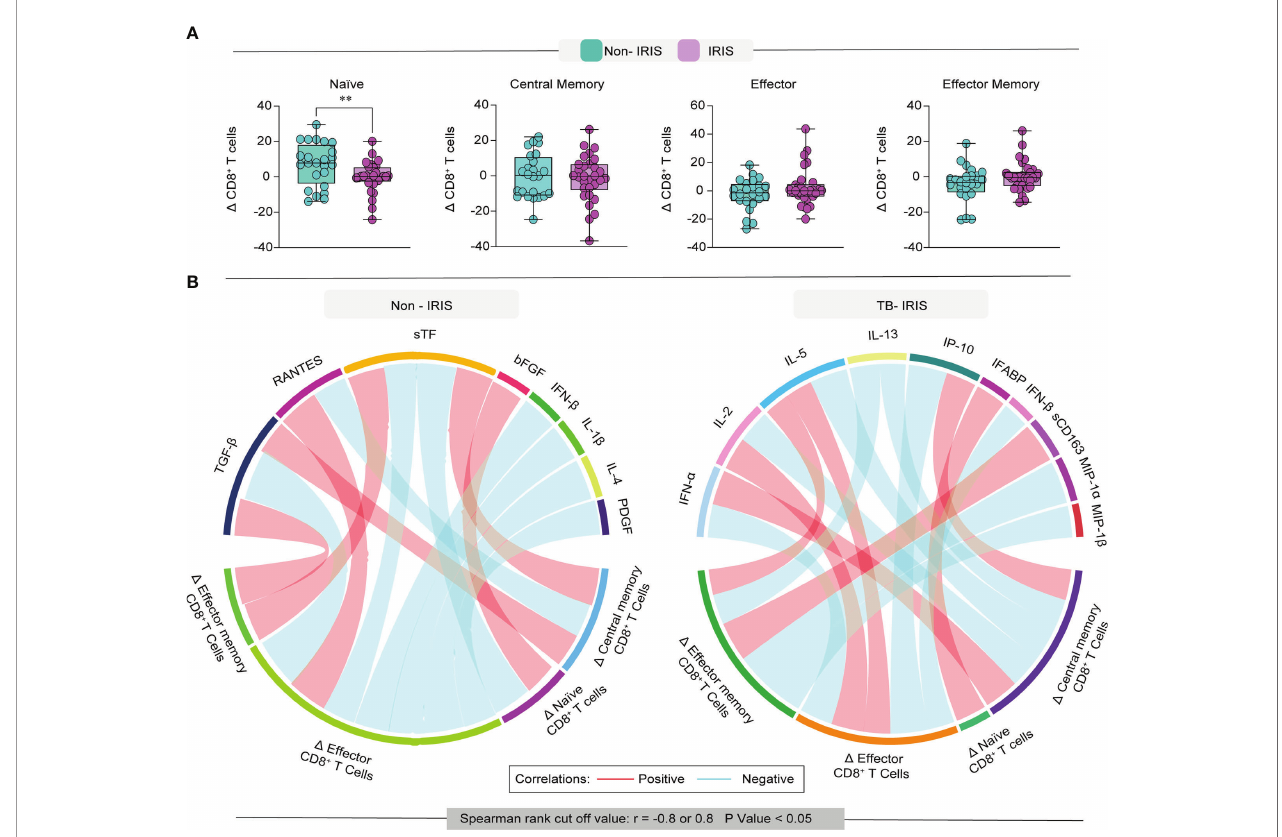
FIGURE 4 | Evaluation of the degree of immune reconstitution in memory CD8 + T cells. (A) Boxplot depicts the delta (frequency timepoint 1 – frequency baseline) of each memory subset in our study population. (B) Network analysis of CD8 T cell memory subsets and association with in fl ammation-related molecules; correlation matrices were developed with bootstrap (100×). Networks depicting only signi fi cant correlations (p < 0.05). Data were analyzed using the T-test (**p <